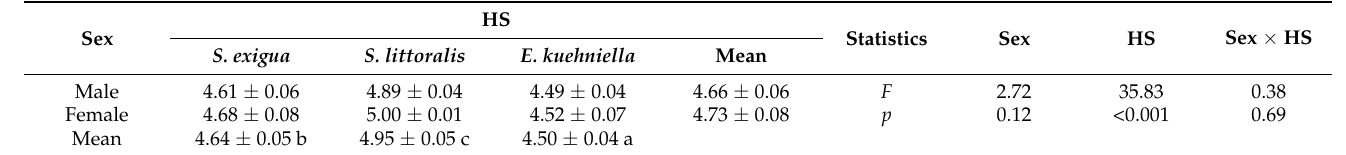
Table 3. Influence of the parasitoid sex and host species (HS) on the body length (mm) of Chelonus inanitus adults (mean ± SEM).